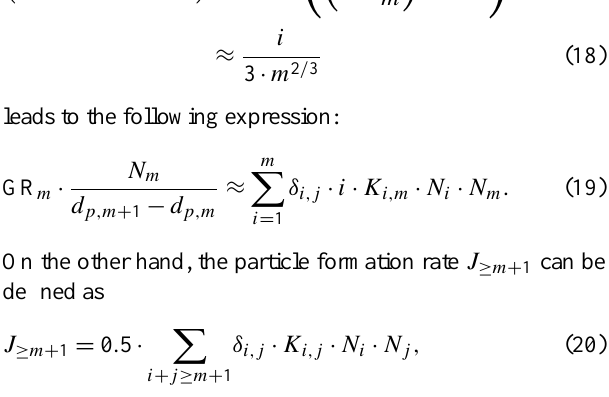
Figure 3. (a) Particle formation rate J ≥ m + 1 due to collisions of monomers and clusters. (b) Approximation of the particle formation rate including the growth rate definition according to Eq. (19). See text for